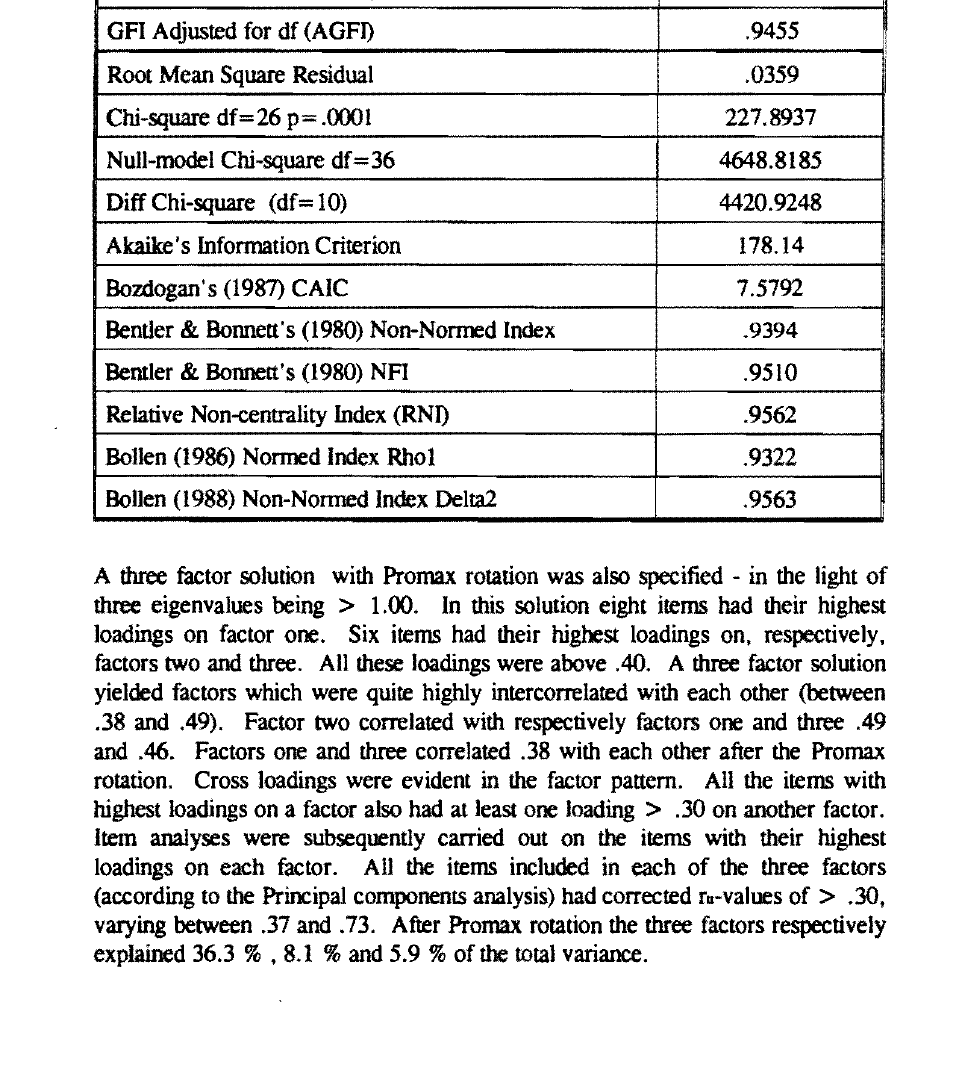
Indkes obtained from Confirmatory Factor Analysis on one factor solution (Kanungo's Job Involvement